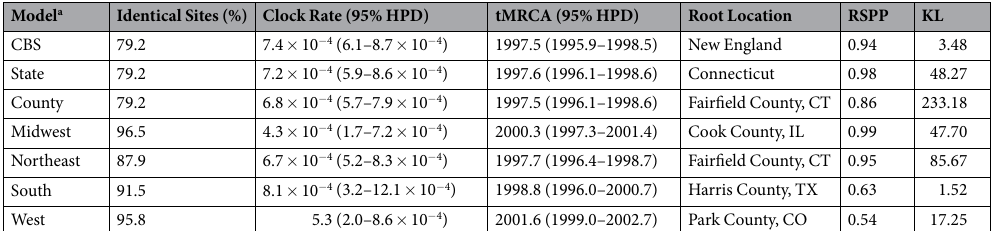
eny for each model to FigShare (https://figshare.com/projects/WNV_GLM_Aggregation_Study/19201). The three national models demonstrate similar trends in population demographics via Bayesian Skyline plots as well. The genetic diversity shows a sharper decline in the county model than the CBS or state models near the year 2003, but the remainder of the Skylines are nearly identical among the three models. We provide the Bayesian Skyline plots for the national and regional models on FigShare (https://figshare.com/projects/WNV_ GLM_Aggregation_Study/19201). The Skyline plot of the Northeast county-level model appears similar to that of the three national models over its time frame, which is likely an artifact of the density of samples in the Northeast region compared to the other three regions. The Midwest, South, and West models show generally steady levels of diversity across their respective time periods. While the phylogenies for the CBS, state, and national county models show generally consistent results, this is not true of the predictors included in these three models. Predictor Support Metrics.